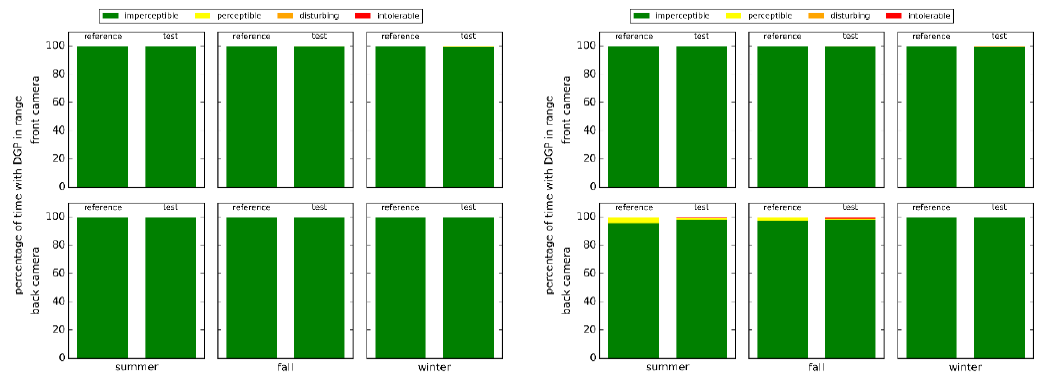
Figure 15. Daylight glare probability (DGP) for CorePlus-S ( left ) and CorePlus-W ( right ).